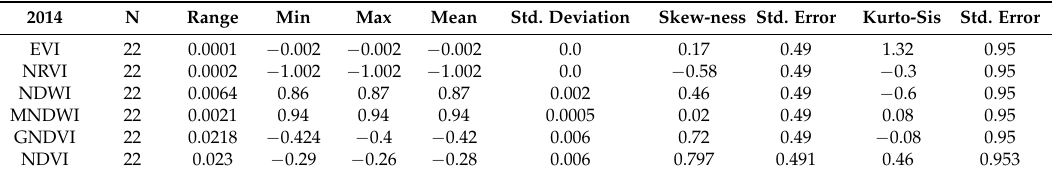
Table 8. Descriptive statistics-Summary tables of selected spectral indices calculated from satellite image of 2014.